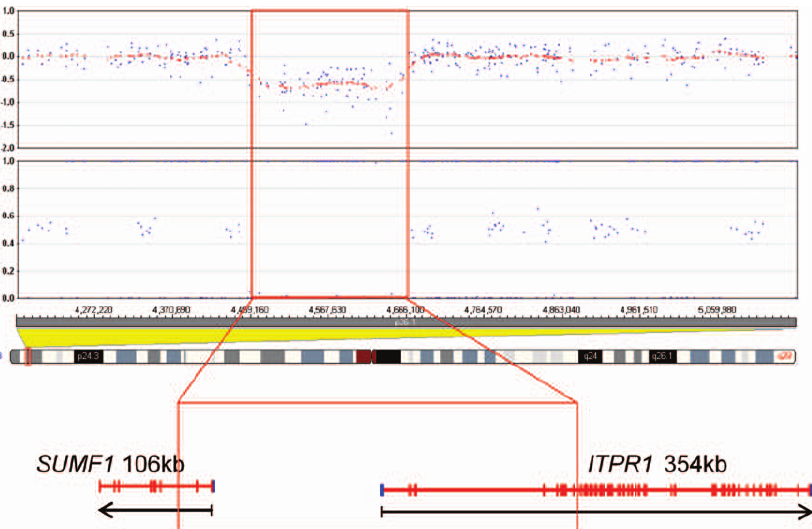
Figure 2. Metrics Derived from Analysis of DNA from Affected Family Member 7 Using Illumina Infinium HumanHap550 Genotyping Chips The upper and lower plots are log R ratio and B allele frequency, respectively, at an ; 800-kb segment on the p arm of Chromosome 3. Log R ratio is the ratio of normalized, observed R to expected R for each SNP (each SNP is a blue dot) and thus serves as a surrogate of copy number at each locus. B allele frequency is a measure of the number of times the A or B alleles are detected at each locus (each SNP is denoted by a blue dot). Thus, SNPs with a B allele frequency of one are apparent B/B homozygotes, SNPs with a B allele frequency of 0.5 are apparent A/B heterozygotes, and those with a B allele frequency of zero are apparent A/A homozygotes. Clearly, these plots show a contiguous region ; 200 kb long with decreased copy number and apparent homozygosity (bounded by a red box). As we have demonstrated previously, this is indicative of a heterozygous genomic deletion [15]. Below these plots is a schematic of the two known genes affected by this deletion, ITPR1 and SUMF1 .